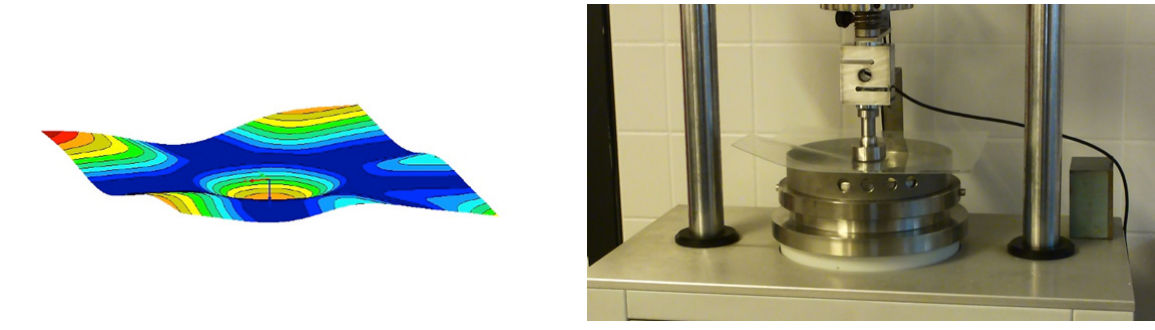
Fig. 13 Imperfection of glass sample and